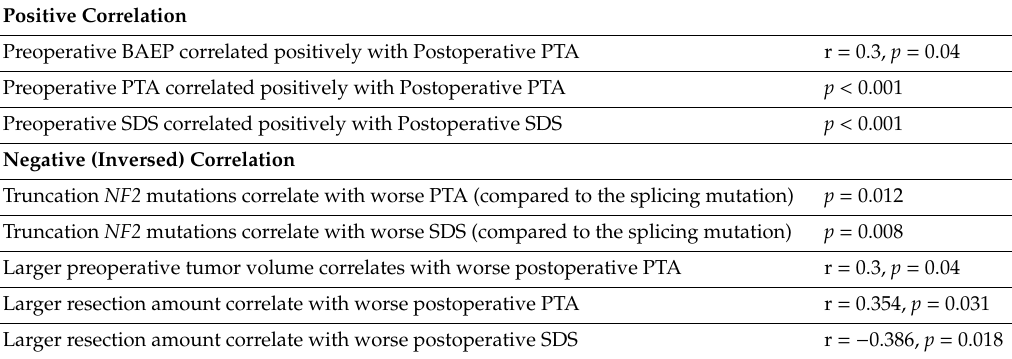
Table 3. Correlations of parameters / features with postoperative